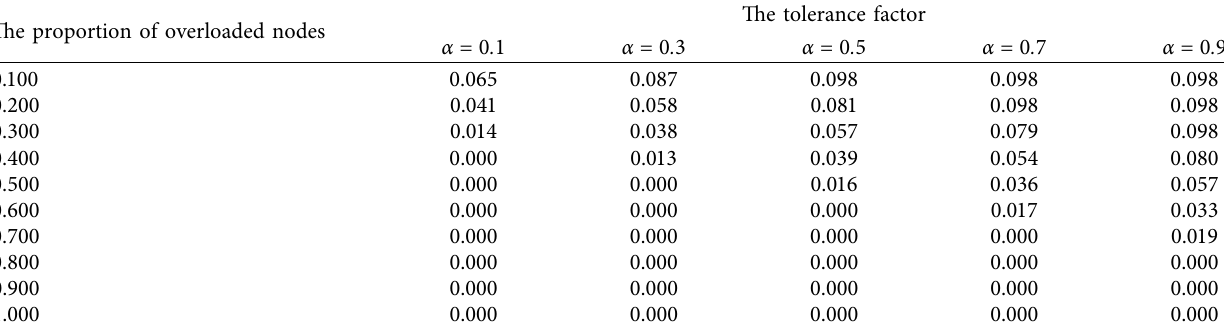
Table 9: Average network efficiency (b).